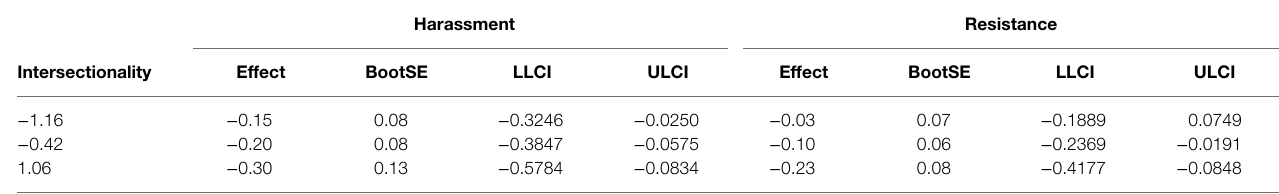
TABLE 5 | Moderated mediation results examining conditional indirect effects of harassment (left panel) and resistance (right panel) on career choice via psychological safety at different levels of the moderator intersectionality.